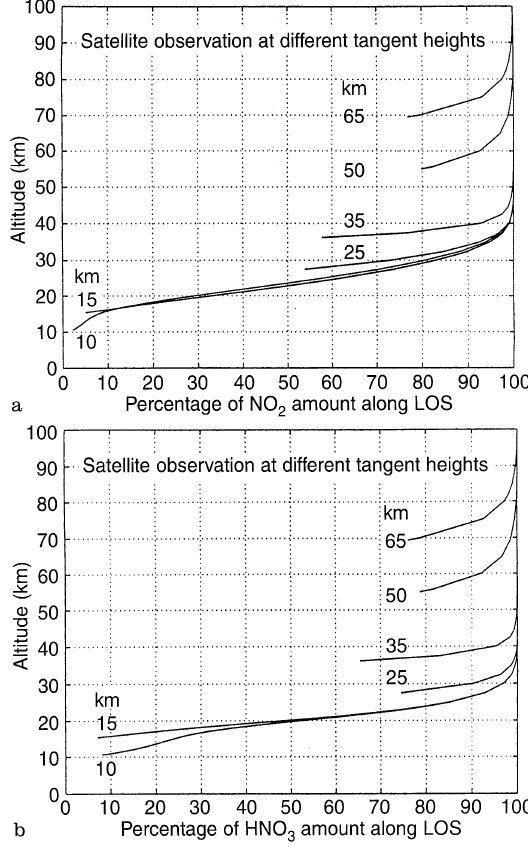
Fig. 4a, b. Growth of the accumulated molecular amount along the line-of-sight (LOS) versus altitude above earth’s surface, for a satel- lite limb observation (from MIRAS) at different tangent heights (TGP) of a NO (cid:50) , b HNO